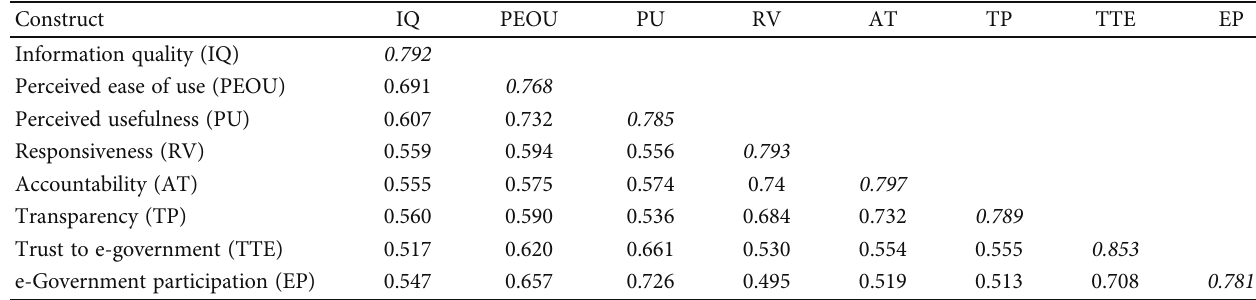
Table 4: Discriminant validity with the Fornell-Larcker